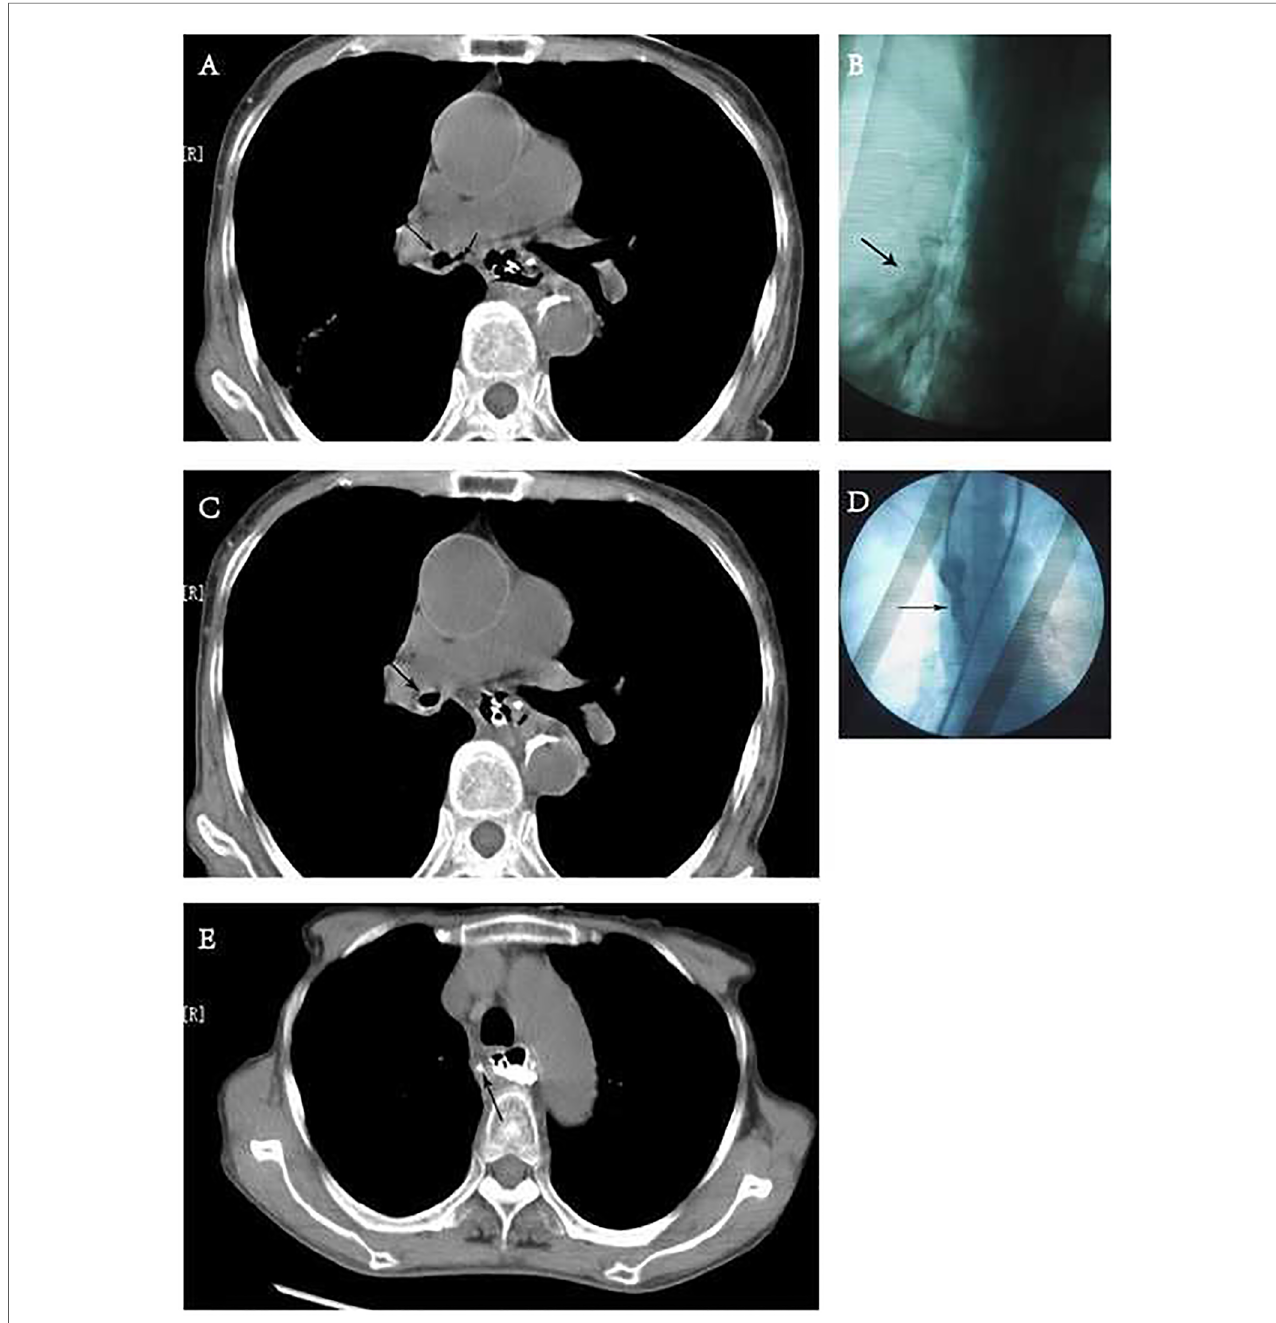
FIGURE 1 Chest computed tomography (CT) and fl uoroscopy. ( A ) CT showed the bronchus communicate with mediastinal abscess. Long arrow: right inferior bronchus. Short arrow: mediastinum. ( B ) Dimeglumine fl owed into right low lobe via mediastinal drainage tube through right inferior bronchus in chest fl uoroscopy. Arrow: dimeglumine. ( C,D ) CT and fl uoroscopy (pulled dimeglumine via mediastinal drainage tube) showed the fi stula of bronchus is healed. ( E ) CT showed mediastinal abscess was healed after oral dimeglumine. Arrow: sinus tract after removing mediastinal drainage